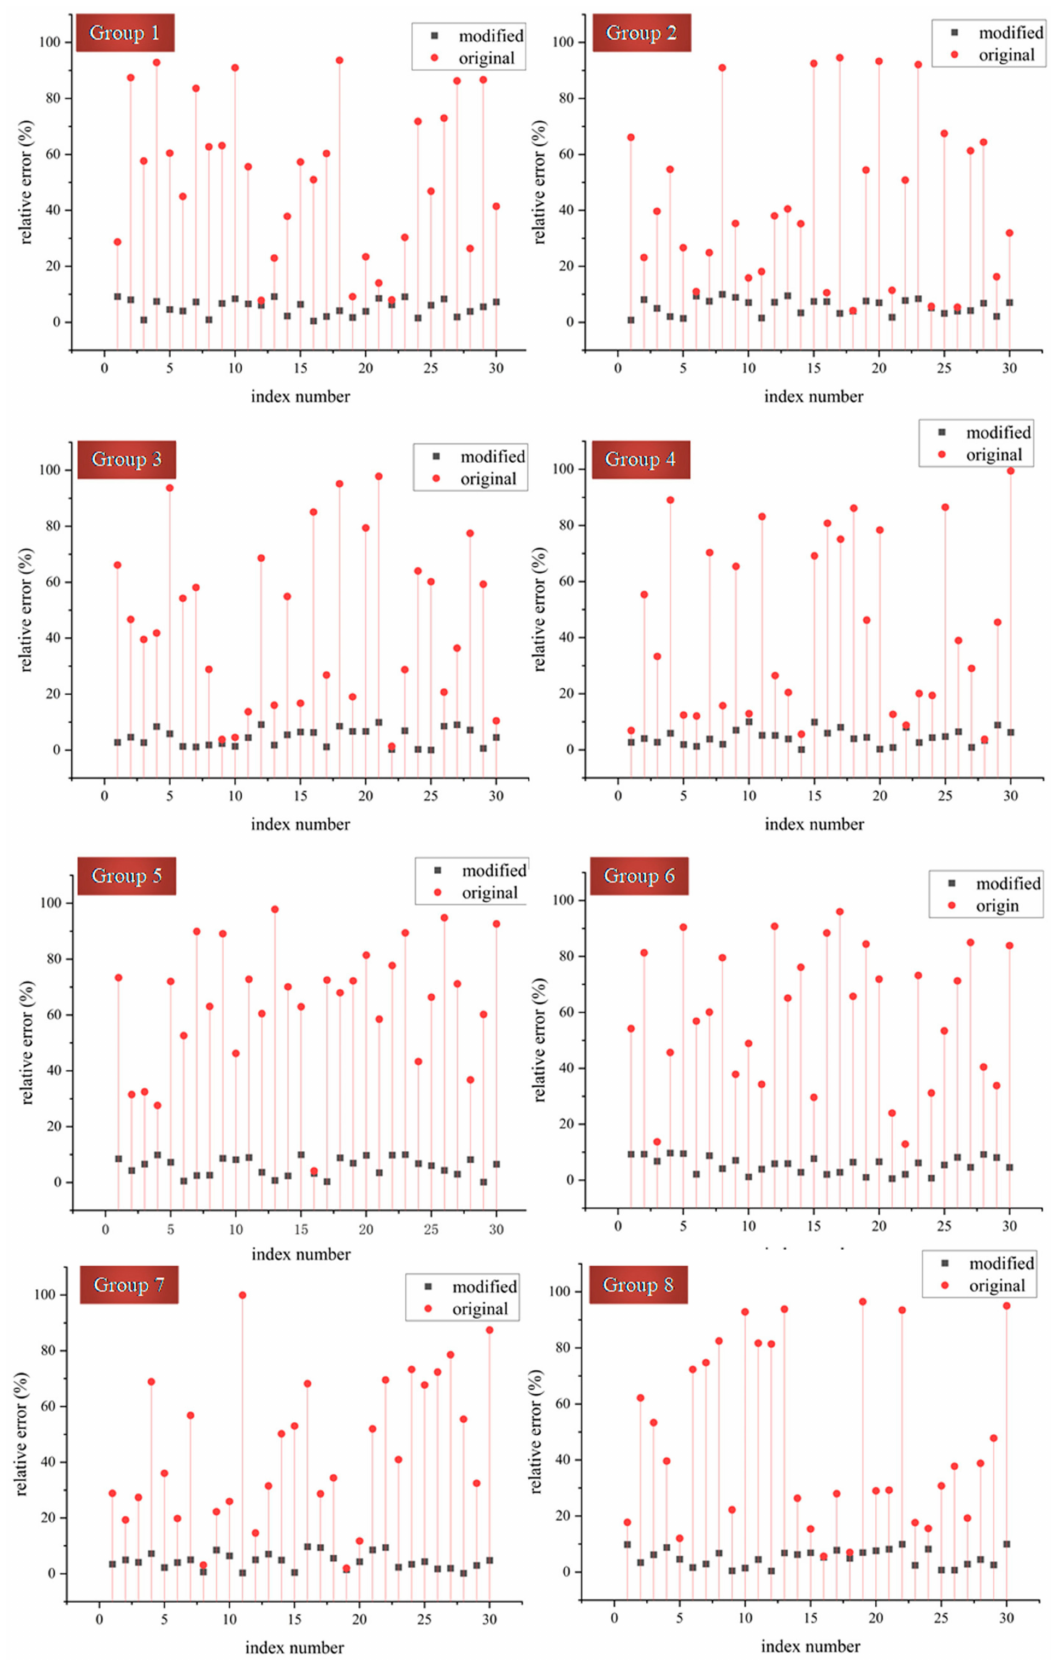
Figure 7. The comparison of model accuracy based on the experienced data along the y